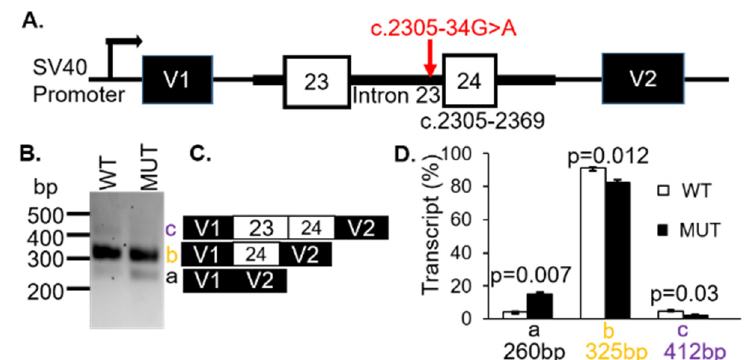
Figure 3. The CNGB1 c.2305-34G>A VUS affected splicing efficiency. ( A ) Diagram showing the genomic region amplified from the patient’s genomic DNA, cloned into the pSPL3 vector. ( B ) Representative analysis of mRNA from COS7 cells transfected with wild type (WT) or mutant (MUT) genomic sequences. ( C ) Products identified with Sanger sequencing. ( D ) Transcript (%) relative to total transcripts was significantly different between WT and MUT.